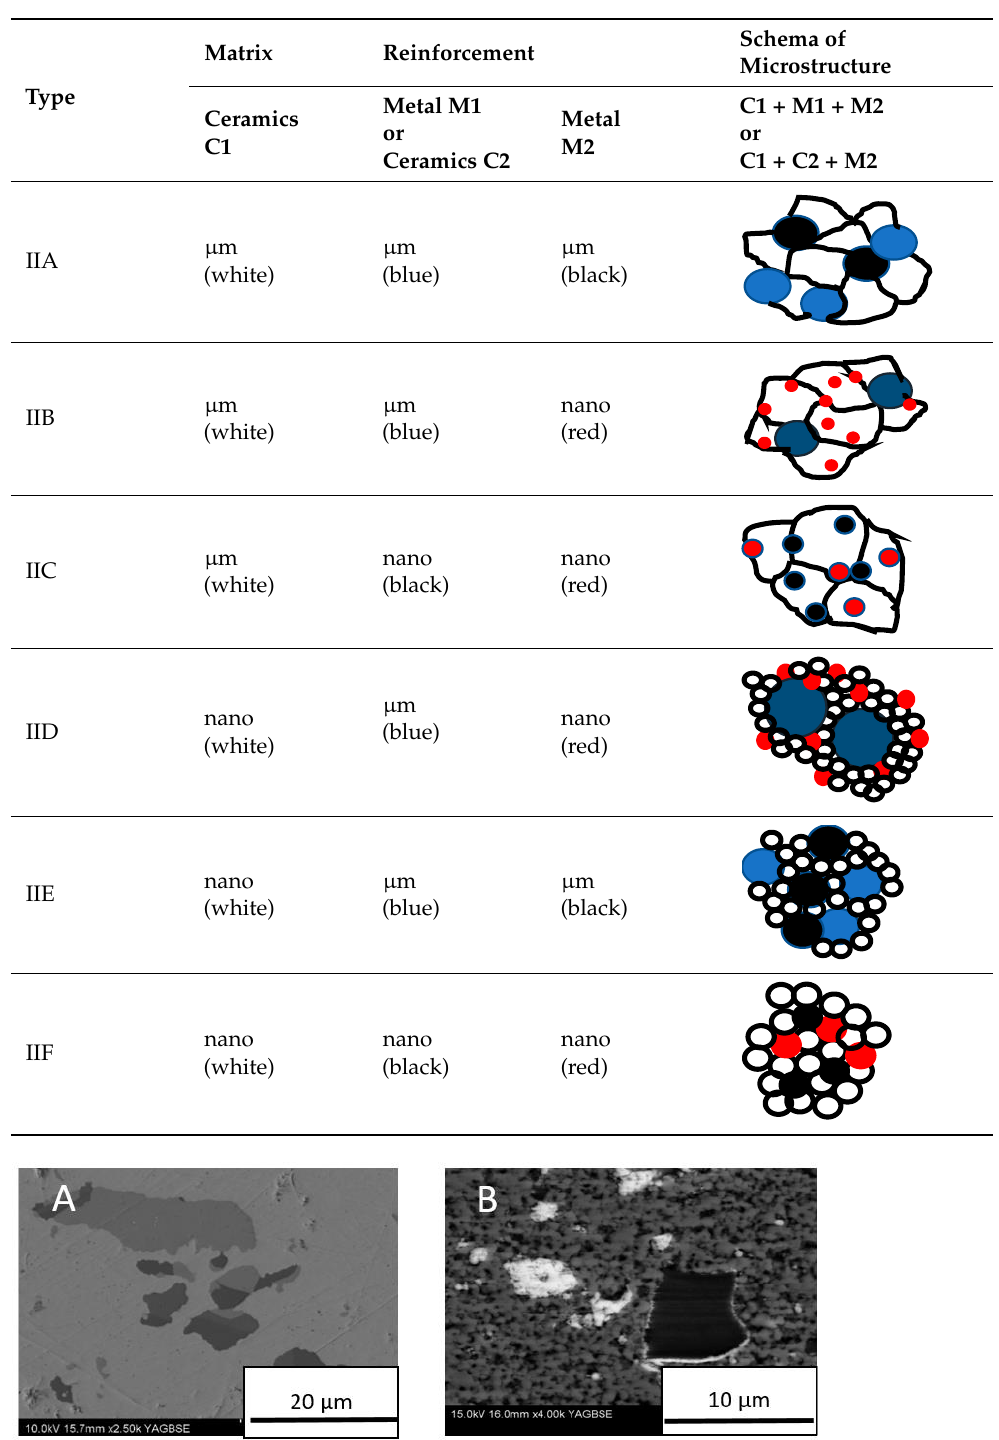
Figure 5. SEM images of ceramic–metal composites microstructures: ( A ) composite ZrO 2 ‐ Ti ‐ Ni, matrix ZrO 2 (light grey), Ti particles (dark grey) and Ni particles (grey); ( B ) composite Al 2 O 3 ‐ TiC ‐ Ti, matrix Al 2 O 3 (dark grey), Ti particles (white), TiC particles (black). Source: results obtained under supervision of K. Konopka.